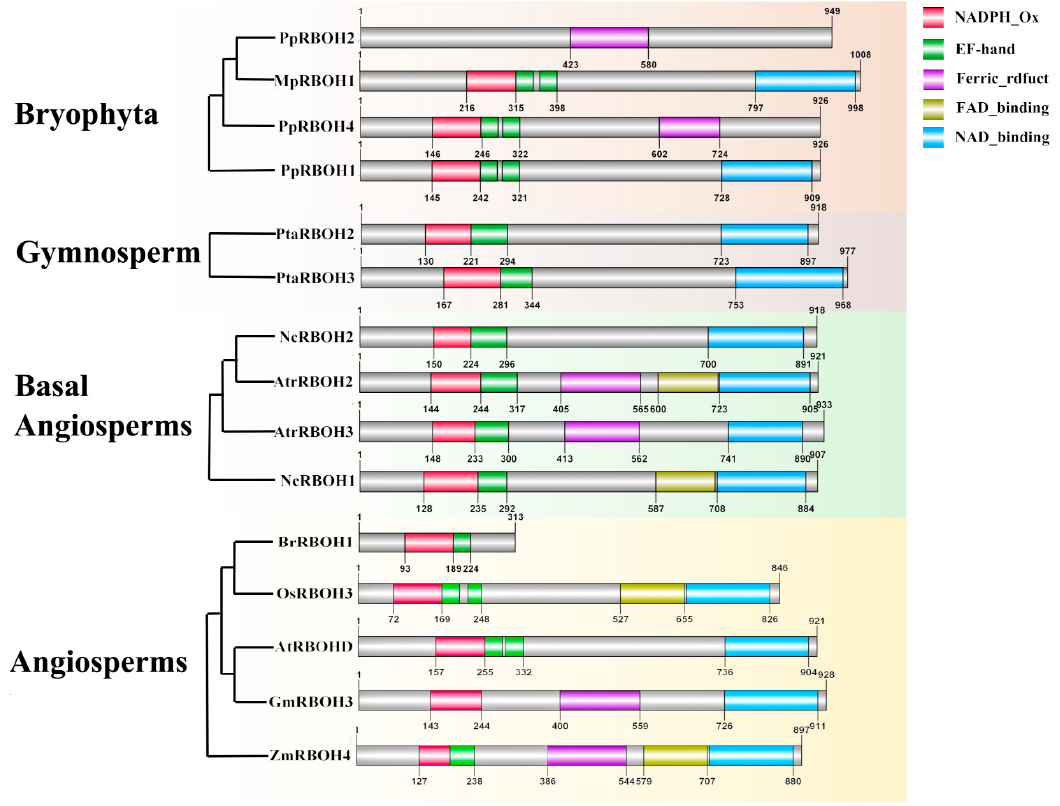
Figure 2. Conserved domains of the representative RBOHs in plants.